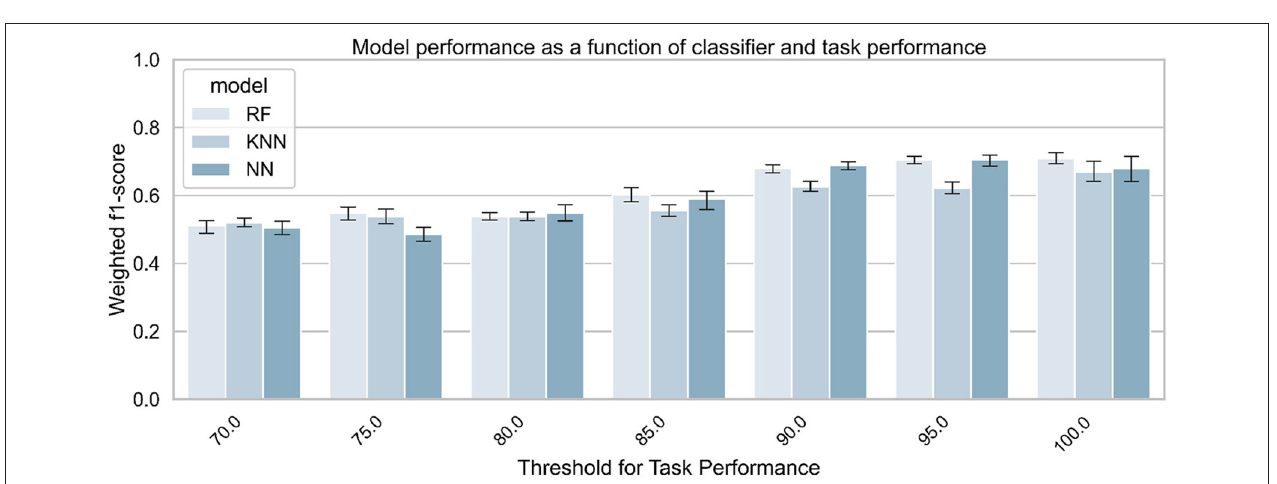
FIGURE 8 | Classifiers’ performance for predicting task difficulty (no task vs. 1- vs. 3-back), as a function of classifier and task performance. The three signals (EDA + ECG + RESP) were used to train the classifiers.